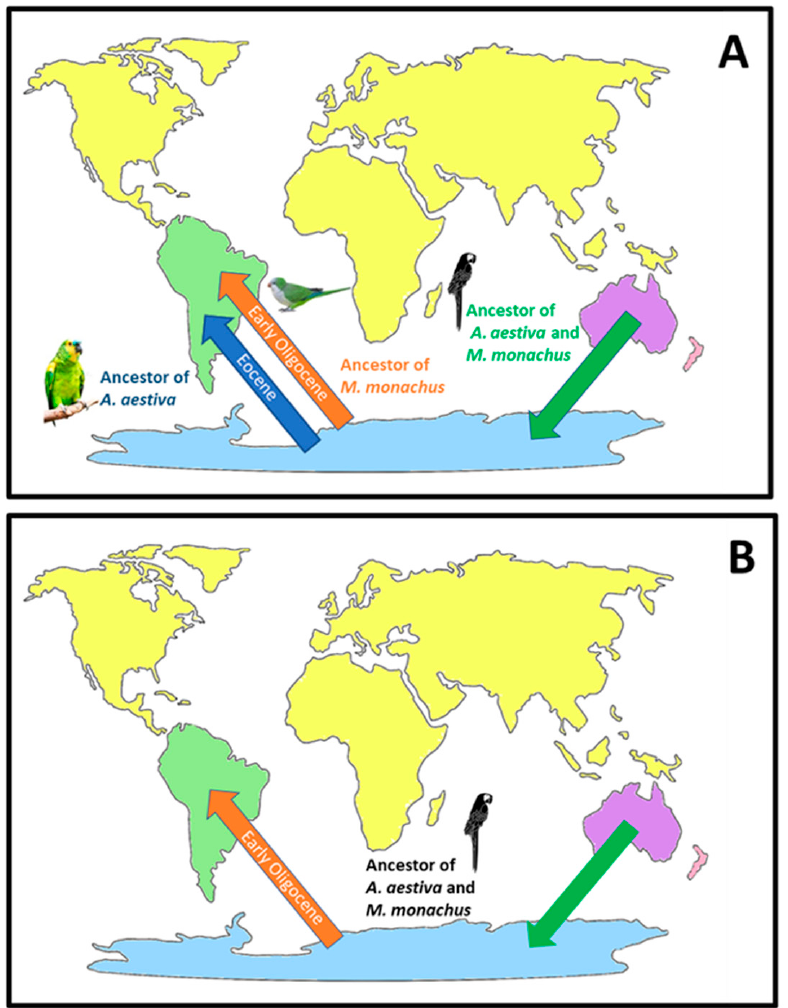
Figure 6. Hypotheses suggested for A. aestiva and M. monachus evolutionary radiation. Panel ( A ): the ancestors of A. aestiva and M. monachus migrated from Australia to Antarctica (green arrow). The ancestor of A. aestiva migrated from Antarctica to South America before the dramatic cooling event occurred during the Eocene-Oligocene transition that led to the progressive aridification of Antarctica and Australian landmasses (blue arrow). The ancestor of M. monachus migrated from Antarctica to South America after this climate change event (orange arrow). Panel ( B ): the ancestors of A. aestiva and M. monachus migrated from Australia to Antarctica (green arrow) and then to South America after dramatic climate change events occurred about 30 Mya (orange arrow). Please see the discussion section for further details. For convenience, the current distribution of continents is